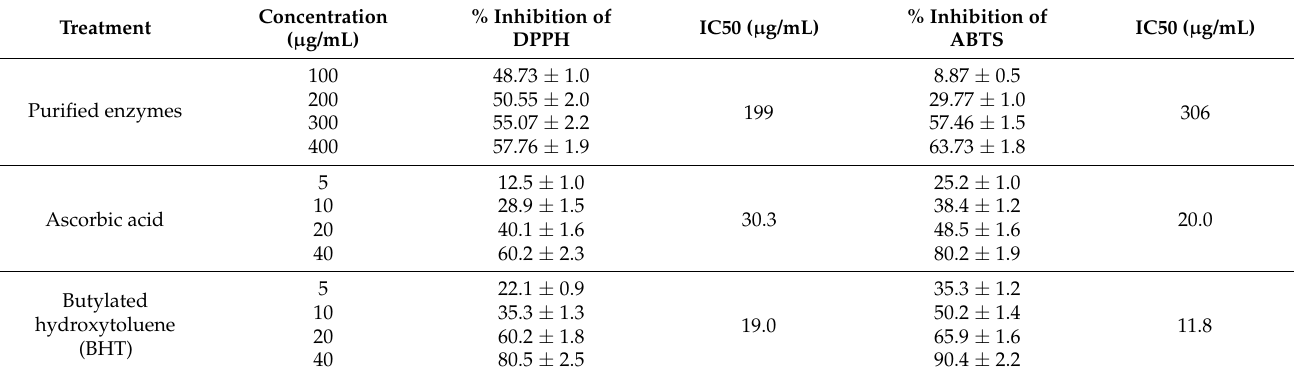
Table 4. Antioxidant activities of purified chitinase produced by T. funiculosus strain CBS 129594 as well as ascorbic acid against DPPH and ABTS at different